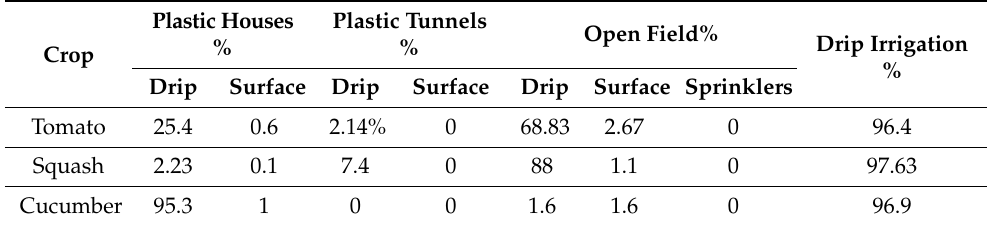
Table 3. Cultivated area percentage of vegetables by type of crop, plantation and irrigation system (DOS,